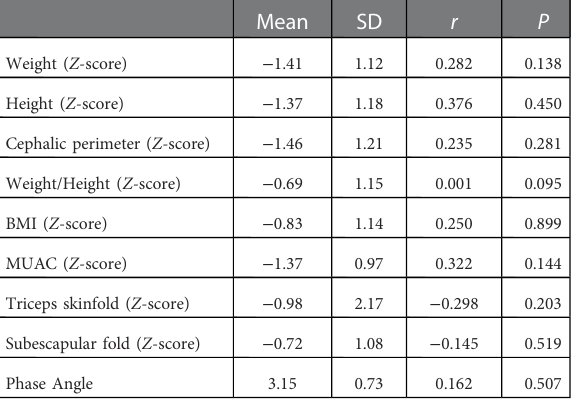
TABLE 3 Correlation of PMI with anthropometric measures and phase angle by BIA.